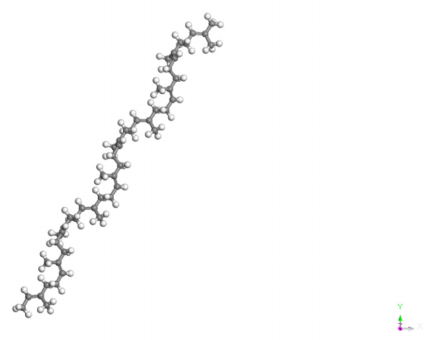
Figure 6. Single chain molecular structure of